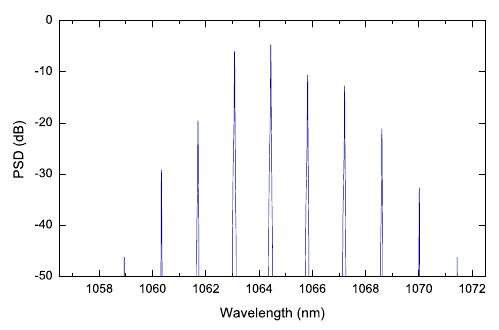
Figure 7: Experimental OSA spectrum around the fundamental mode for quasi-phase-matched SHG in lithium tantalate crystal at 4.5 W of input pump power.